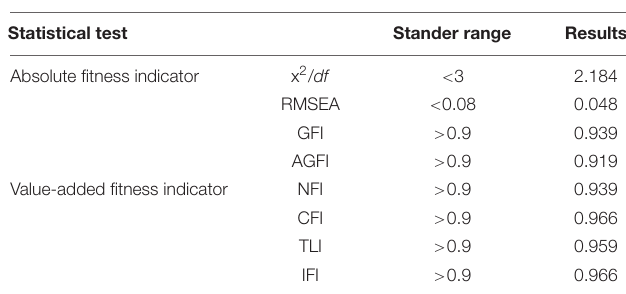
TABLE 5 | Model index.